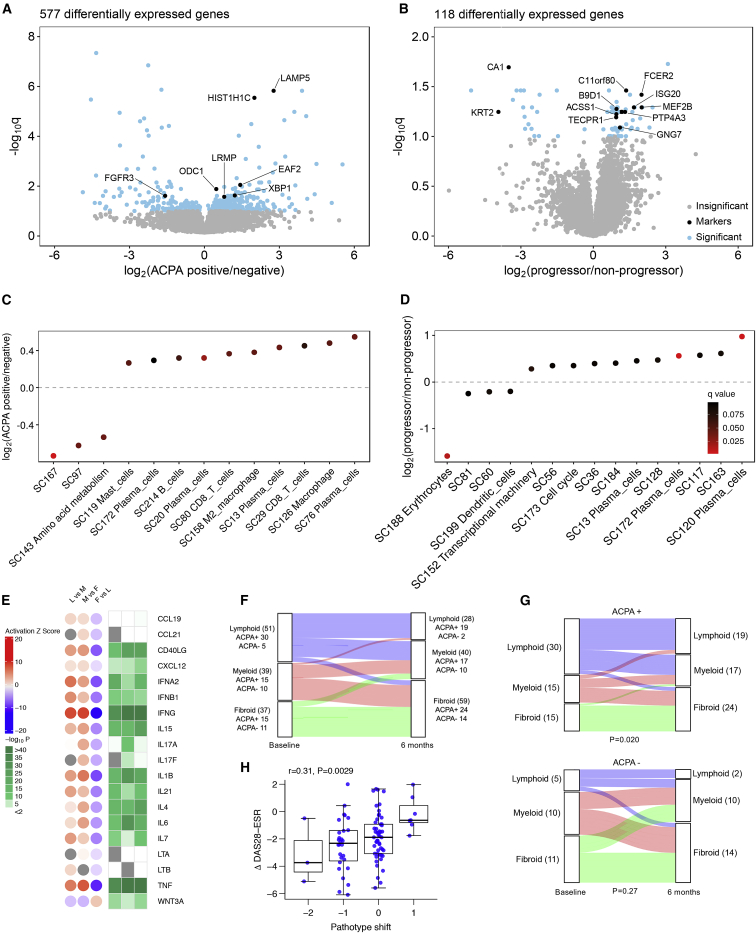
Baseline Synovium Plasma Cell Gene Expression Is Associated with CCP Antibody Positivity and Worse Prognosis at 12 Months(A and B) Differential gene expression in synovium RNA-seq comparing (A) anti-CCP antibody (ACPA)-positive and ACPA-negative RA individuals and (B) individuals with progression of bone erosions on X-rays at 12 months compared to baseline versus non-progressors.(C and D) Single-cell RNA-seq-annotated WGCNA modular analysis shows that increased plasma cell module expression is associated with ACPA positivity (C) and is predictive of bone erosion radiographic progression at 12 months (D).(E) Upstream regulator analysis using Ingenuity Pathway Analysis showing upstream regulator effects of cytokines and chemokines associated with ectopic lymphoid structure development in synovium.(F and G) Sankey diagrams showing change in histological pathotype following 6-month treatment with disease-modifying anti-rheumatic drugs (DMARDs) for (F) whole cohort or (G) grouped by ACPA status. Statistical analysis by Fisher’s test.(H) Shift in pathotype between baseline and 6 months correlated against change in DAS28-ESR. Statistical analysis by Pearson correlation.